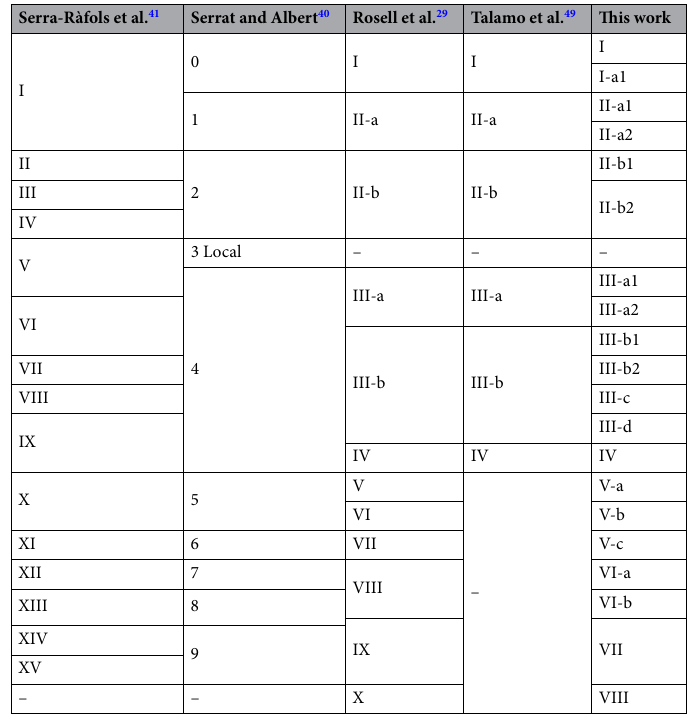
Table 1. Correlation between the units and subunits defined by Serra-Ràfols et al. 41 , Serrat and Albert 40 , Rosell et al . 29 , Talamo et al. 49 , and this